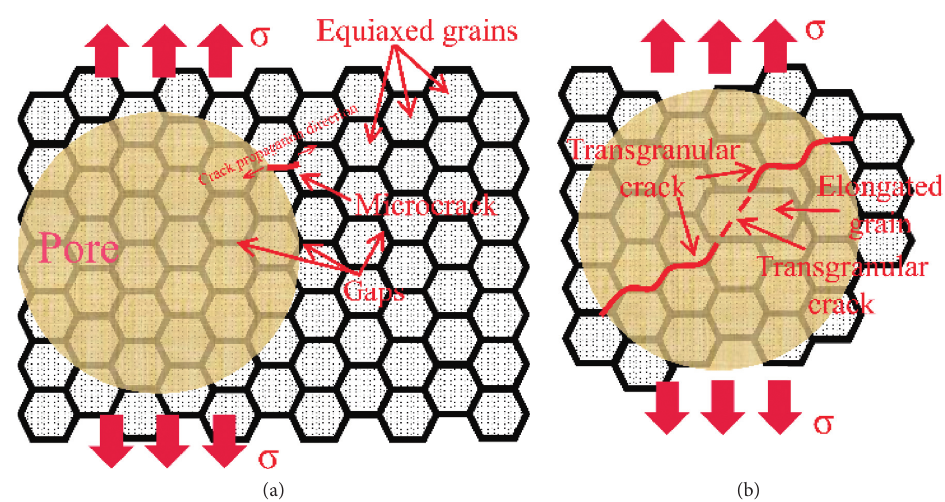
Figure 14: Mechanism of initiation and propagation of cracks at pores.